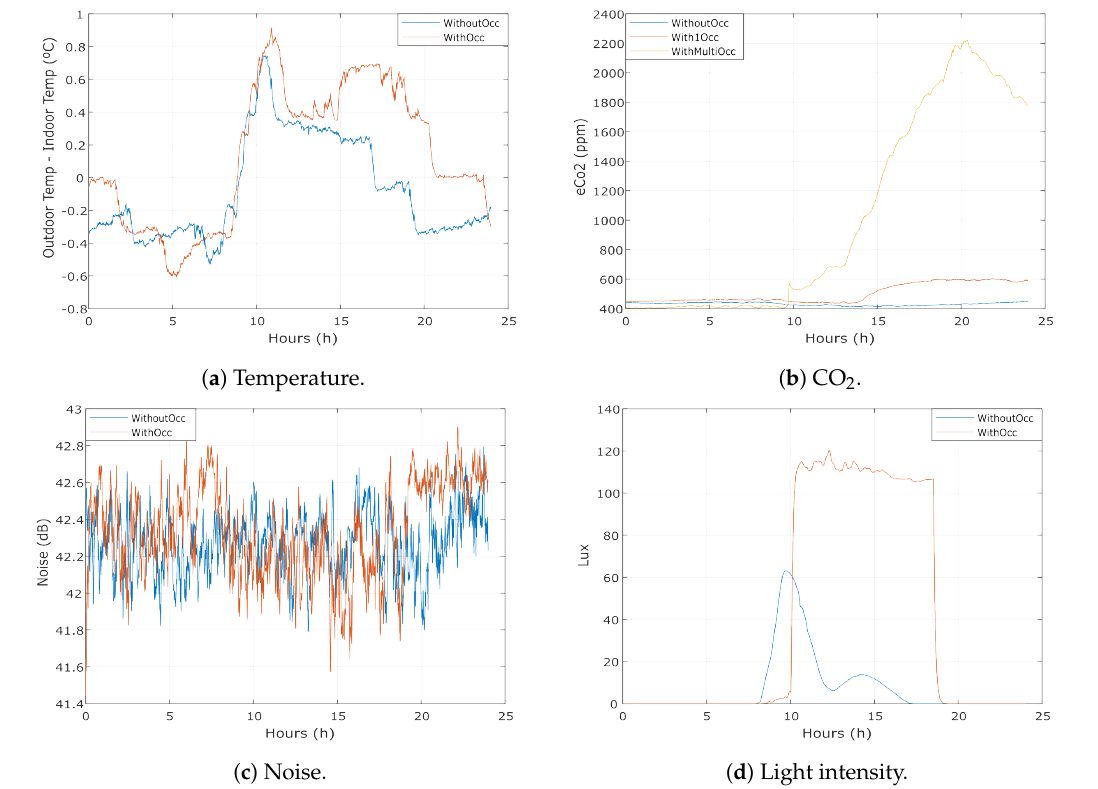
Figure 6. Processing and analysis of the environmental data